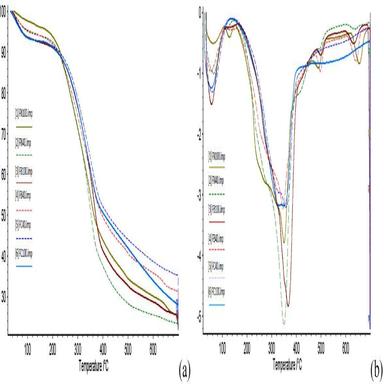
TG (a) and DTG (b) curves of fir bark, needles and cones.